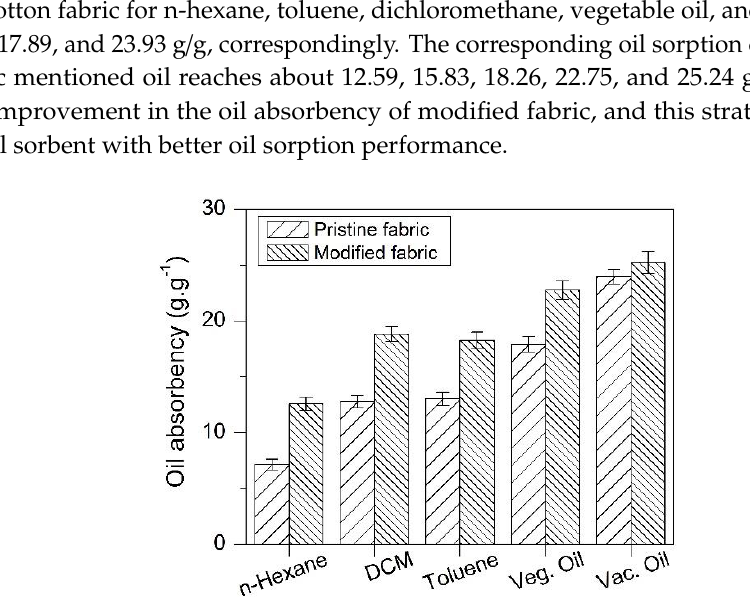
Figure 11. The separation efficiency of modified cotton fabric. 4. Conclusions In summary, a practical top-down approach to fabricate strongly hydrophobic and superoleophilic cotton fabric with PMMA nanoparticles using a simple coating method is demonstrated. Through oil absorption and oil–water separation experiments, DCC/DMAP catalytically modified cotton fabric can be successfully applied to oil–water separation when ethanol